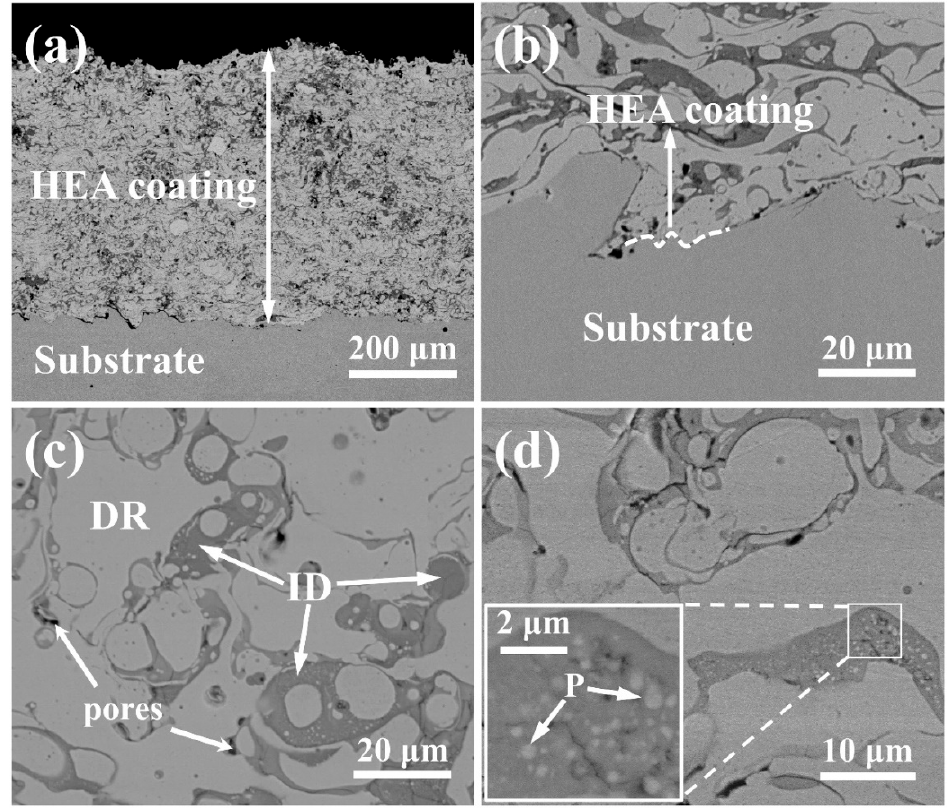
Figure 3. SEM images of (CoCrFeNi) 95 Nb 5 HEA coating: ( a ) longitudinal section, ( b ) high magnification morphology of longitudinal section, ( c ) coating surface, ( d ) high magnification morphology of the coating surface. DR: dendrites with white contrast; ID: interdendrites with gray contrast. Table 1. Nominal compositions and chemical compositions of (CoCrFeNi) 95 Nb 5 HEA powder and coating (at.%).